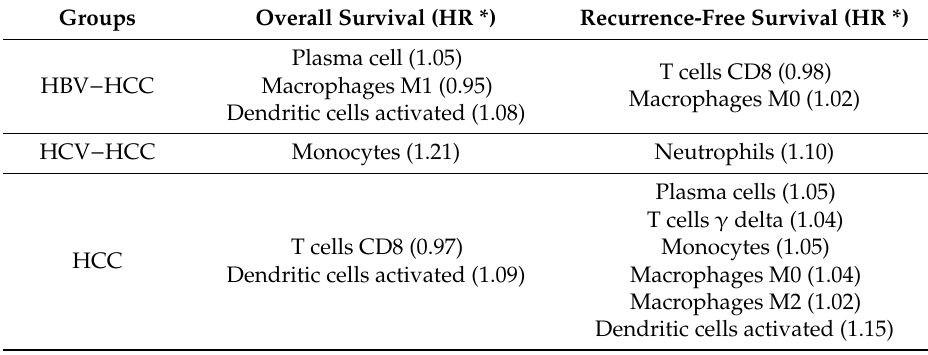
survival of the